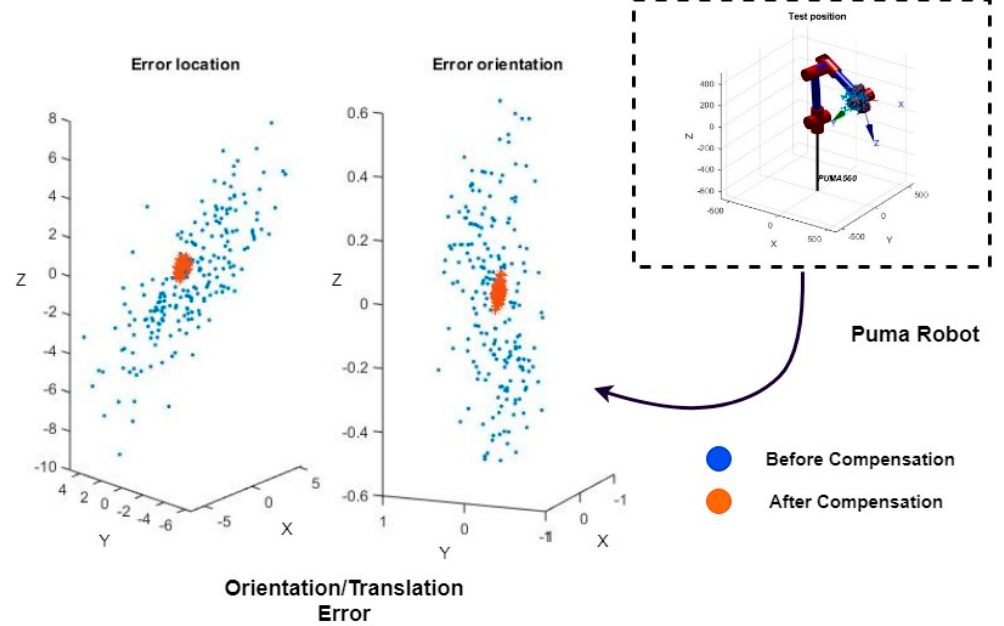
Figure 9. Position / orientation error in 3D space for simulation. Figure 9. Position/orientation error in 3D space for simulation.